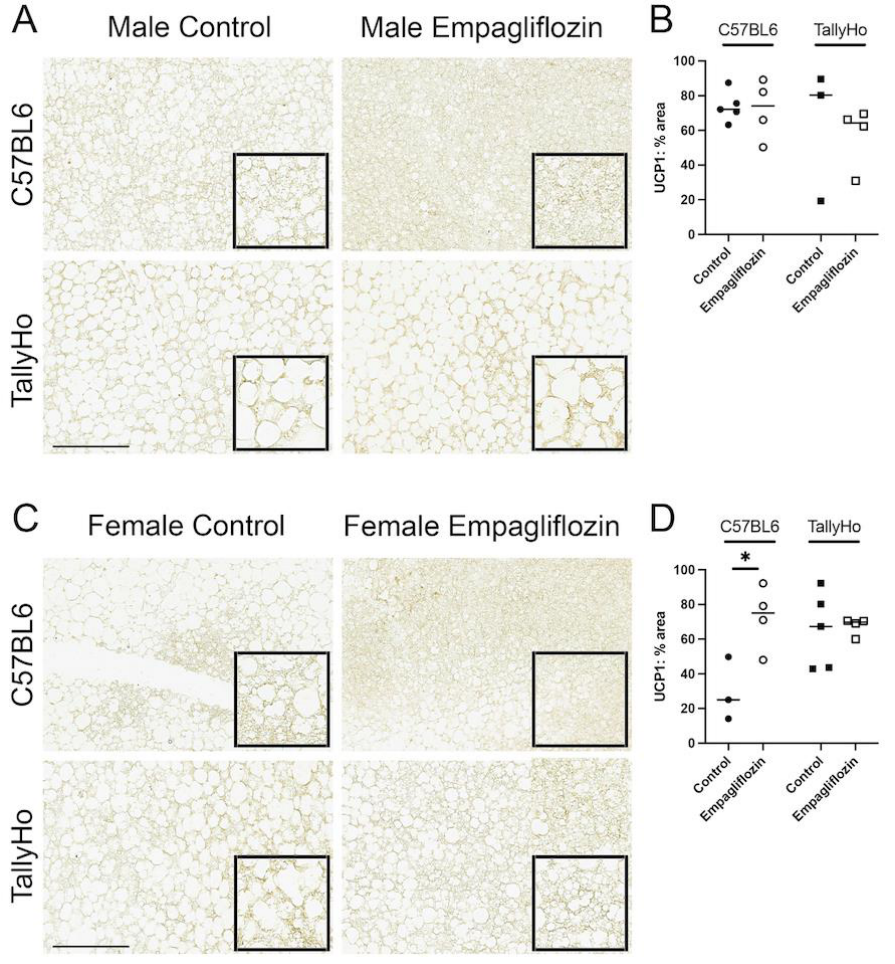
Figure 10. Uncoupling protein 1 (UCP1) is slightly reduced in Empagliflozin-treated TallyHo male mice. Brown adipose was isolated from the nuchal region, paraffin-embedded, and stained for uncoupling protein 1 (UCP1), a protein specifically enriched in brown fat in both male ( A ) and female ( C ) mice. Quantification of UCP1 staining revealed a downward trend in the total area of UCP1 ( B , D ) in TallyHo mice. This expression was increased in C57BL6J female mice ( D ). * p < 0.05; scale bar = 50 um.